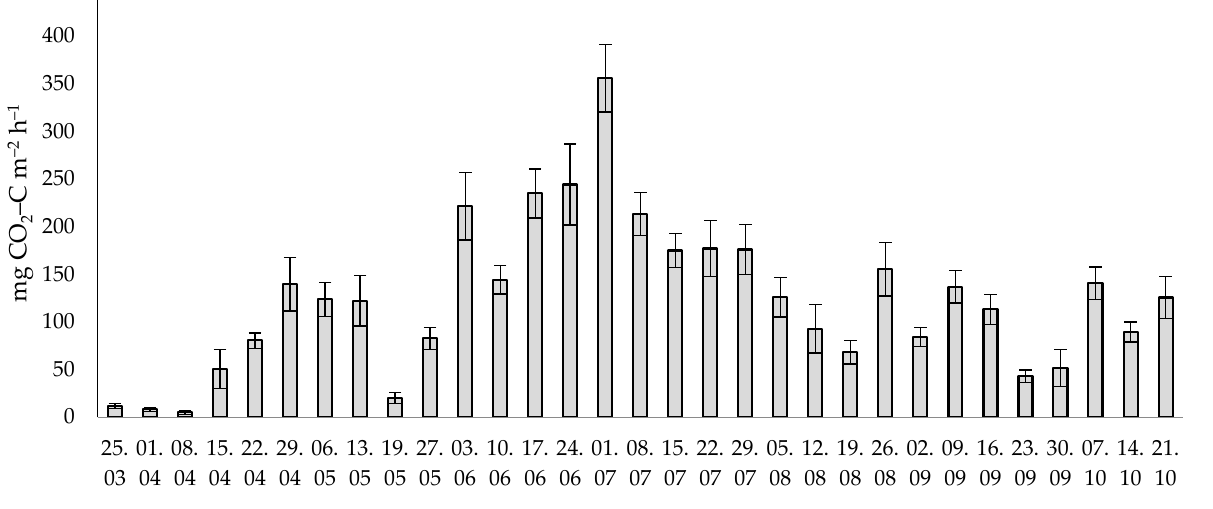
Figure 5. Soil CO 2 fluxes under a pine stand in Mikanów during the dry growing season (2012). Our previous work analyzed CO 2 emissions from arable soil in the same location (Mikanów) [46]. Previously performed studies showed that CO 2 fluxes from arable soil under maize reached 84.58 mg CO 2 -C m − 2 h − 1 with fluctuations ranging from 3.63 to 302.31 mg CO 2 -C m − 2 h − 1 during the growing period. That indicates that under the same weather conditions, approximately 45.9% more CO 2 was released from Scots pine stand soil than from arable soil under corn cultivation. This means that the effectiveness of reducing CO 2 emissions from the soil by afforestation of low-productivity sandy soils may depend more on the amount of CO 2 photosynthetically absorbed by tree stands than soil respiration in dry years. Luyssaert et al. [36] estimated the average net primary production (NPP) for EU-25 forests, which expresses the difference between the amount of CO 2 taken during photosynthesis and the amount of CO 2 released by plants during respiration, is 520 ± 75 g C m − 2 yr − 1 . Bolinder et al. [60] showed much lower values of NPP (<350 g C m − 2 yr − 1 ) for boreal forests in Alberta, Saskatchewan, and Manitoba (Canada). However, in all locations, the NPPs calculated for forests were smaller than for annual arable crops. According to Zhou et al. [61], if soil respiration and plant photosynthetic CO 2 accumulation are similar, old-growth forests can still sequester carbon. Recent results of research by Rodtassana et al. [62] showed that the soil respiration of tropical forests in Southeast Asia is a major source of CO 2 emissions from terrestrial ecosystems and could have a major impact on the global carbon balance and climate change. The results of these studies indicate that the amount of CO 2 released from tropical forest soils is greater in older than younger forest stages and periods. In these studies, an increase in soil temperature resulted in an increase in soil respiration only in older stands. According to Yang et al. [63], environmental variables and litterfall production together explain 82.0%, 86.8%, 42.9%, and 34.7% variations of monthly fluxes of total soil respiration, autotrophic respiration, heterotrophic respiration, and litter respiration of tropical forests, respectively. The ratio of autotrophic respiration and total soil respiration increased with soil temperature, but the opposite was true for heterotrophic respiration and total soil respiration and litter respiration and total soil